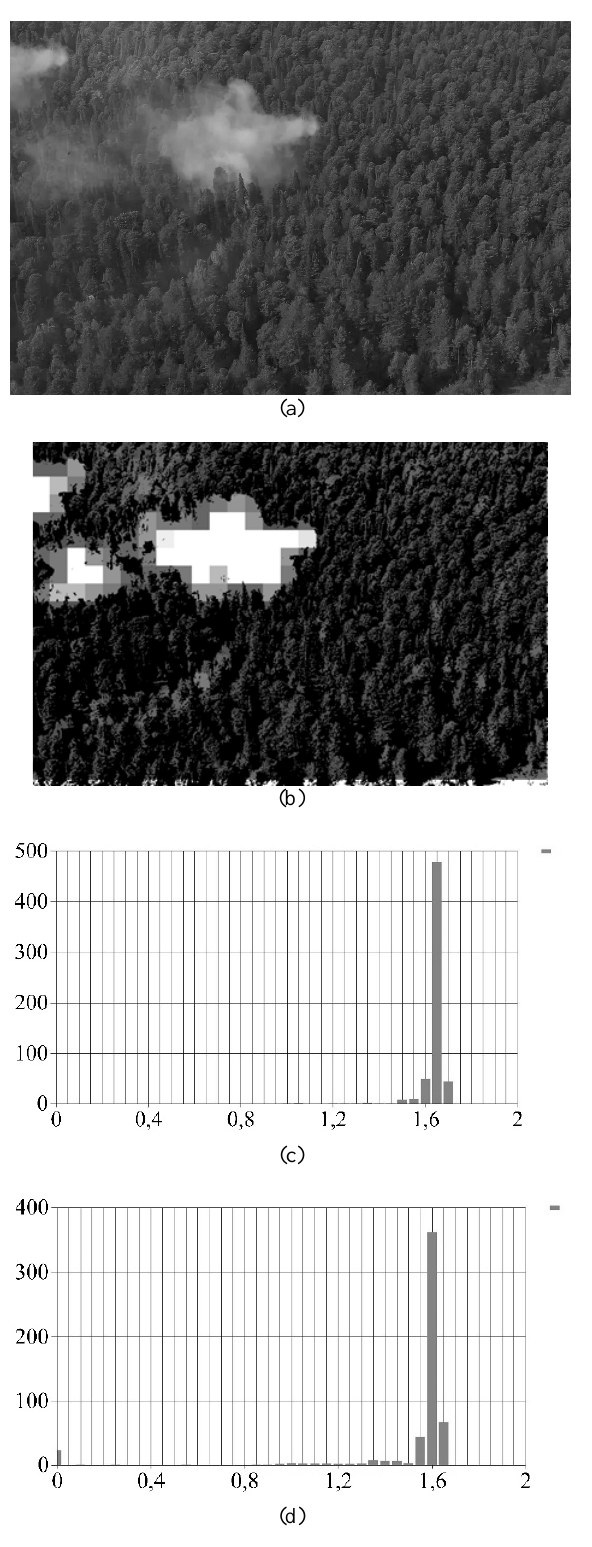
Fig. 2. The results of fractal image analysis (image size - 800 × 541; fractal dimension D estimation display field size 40): (a) the original image; (b) - combined image; (c) - histogram of the fractal image dimension of the original wood; (d) - histogram of the fractal wood image dimension with fire.